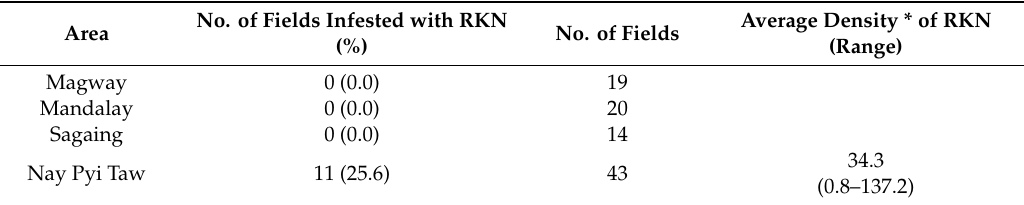
Table 3. Occurrence of root-knot nematodes (RKN, Meloidogyne spp.) in soils of four sesame growing areas in